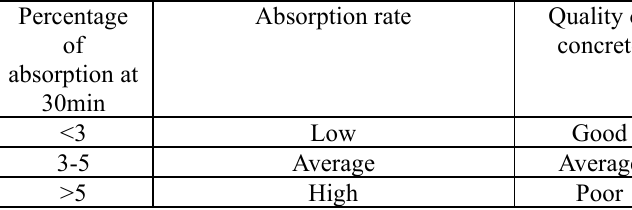
Limits of absorption according to CEB 1989.